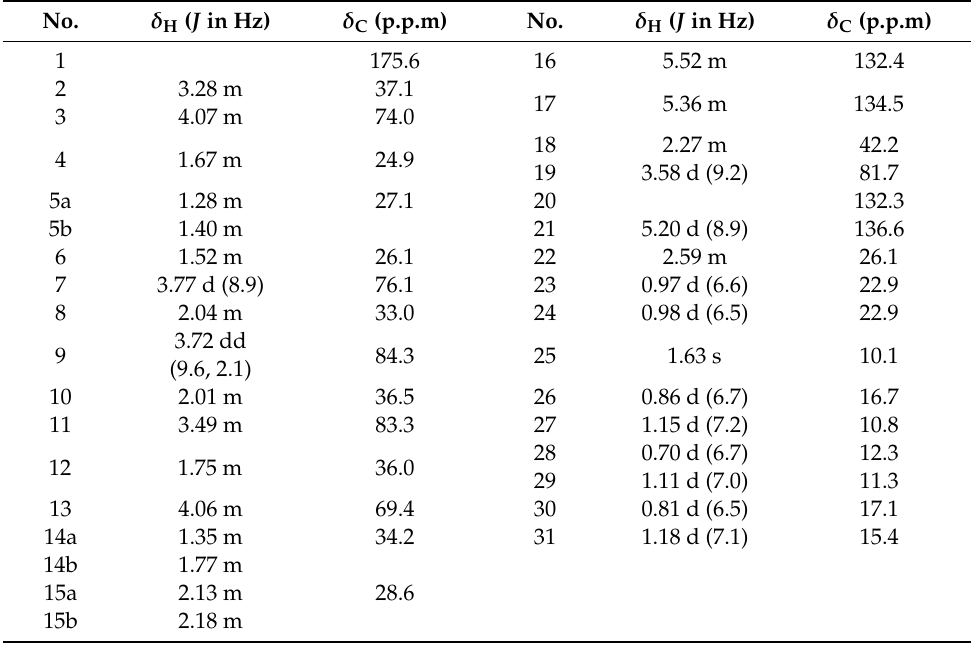
Table 2. 1 H and 13 C NMR data of compound 1 in CDCl 3